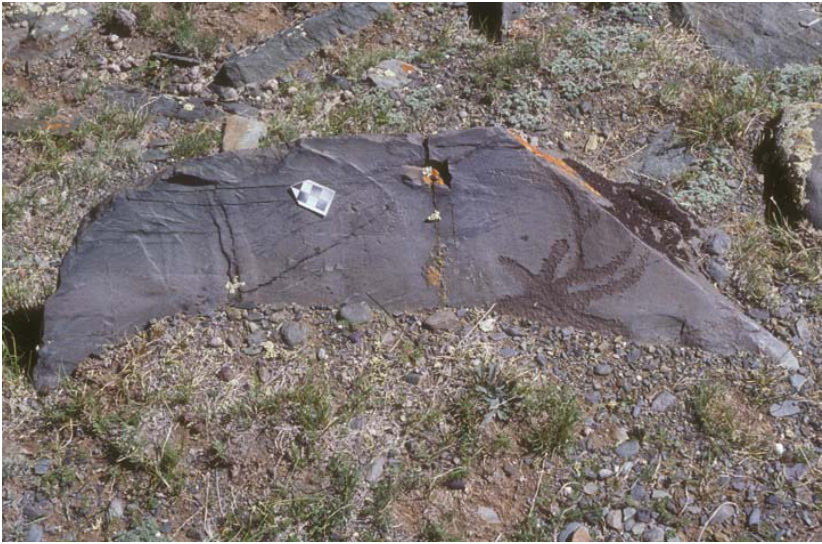
Figure 10. Partially visible image of elk on boulder buried in silt. Early Bronze Age. Tsagaan Salaa III. (http://oregondigital.org/u?/maic,3052).